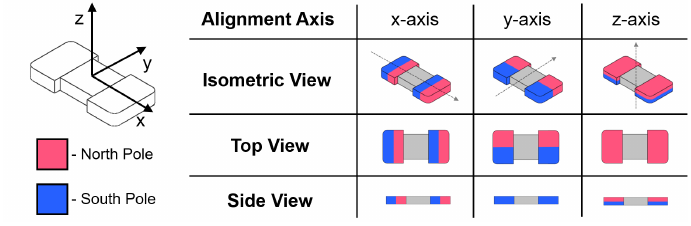
Figure 2. Visualization of internal magnetic alignment along the robot’s three major axes.